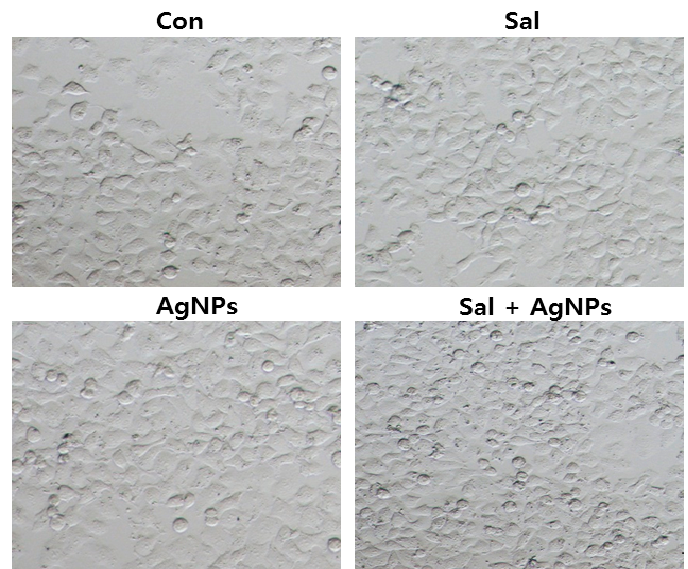
Figure 9. Morphological changes of the human ovarian cancer cell line A2780 after treatment with Salinimycin (Sal), AgNPs, and Sal plus AgNPs. A2780 cells were treated with Sal (3 μ M), AgNPs (3 μ g/mL), and Sal plus AgNPs (3 μ M plus 3 μ g/mL) for 24 h, and the morphological changes of cells were observed under an inverted microscope (200×). The combination of Sal and AgNP induced significant morphological changes.